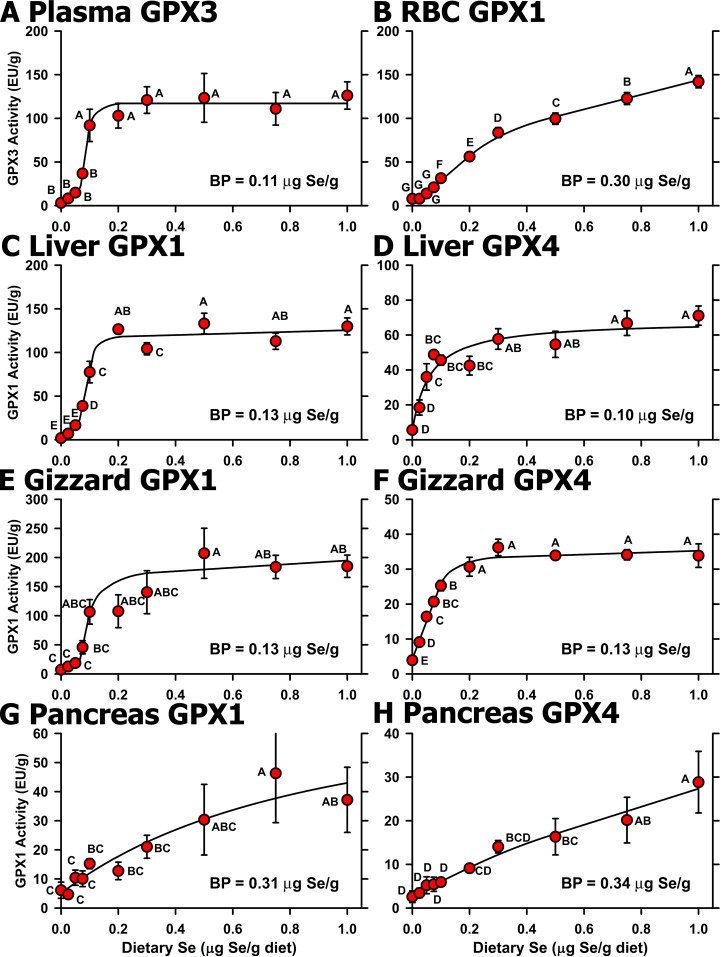
Effect of dietary Se on selenoenzyme activity.Activities for plasma GPX3 (A), RBC GPX1 (B), liver GPX1 (C), liver GPX4 (D), gizzard GPX1 (E), gizzard GPX4 (F), pancreas GPX1 (G), and pancreas GPX4 (H) in chicks supplemented with the indicated graded levels of dietary Se for 29 d. Activities are expressed as enzyme unit (EU)/g protein. Values are the mean±SEM (5/treatment). Means without a common letter are significantly different (P<0.05). Overall level of significance, as determined by ANOVA, is given in Table 3. Se response curve breakpoints (BP) are indicated in each panel, calculated as described in the text.